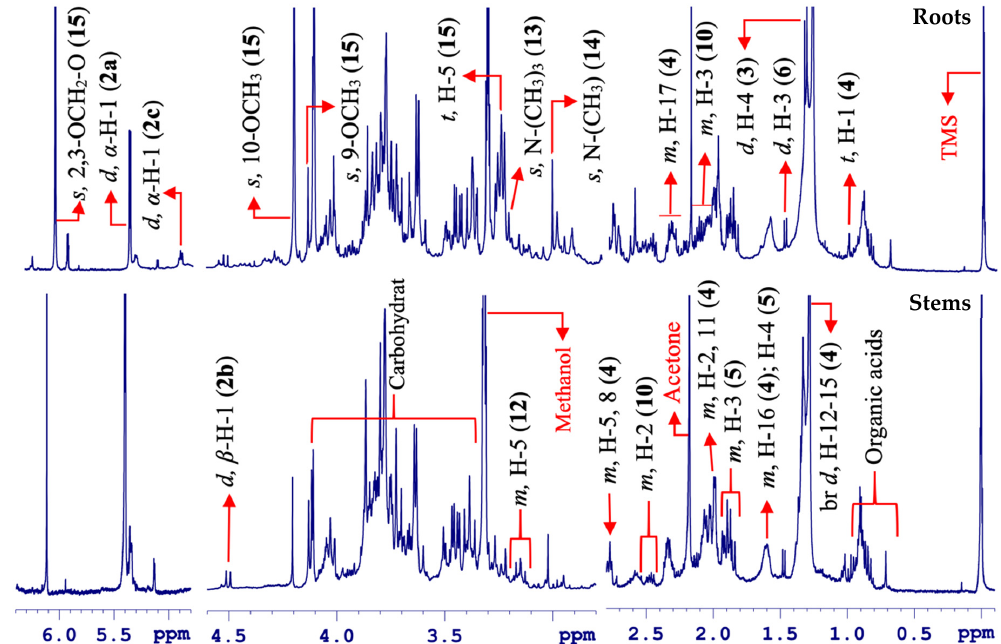
Figure 9. Comparative overview of the amplified olefinic, carbohydrates, and aliphatic regions in the 1 H HR-MAS NMR spectra from the roots and stems of Berberis laurina (400 MHz, ~10 mg swollen in 40-µL CD 3 OD).